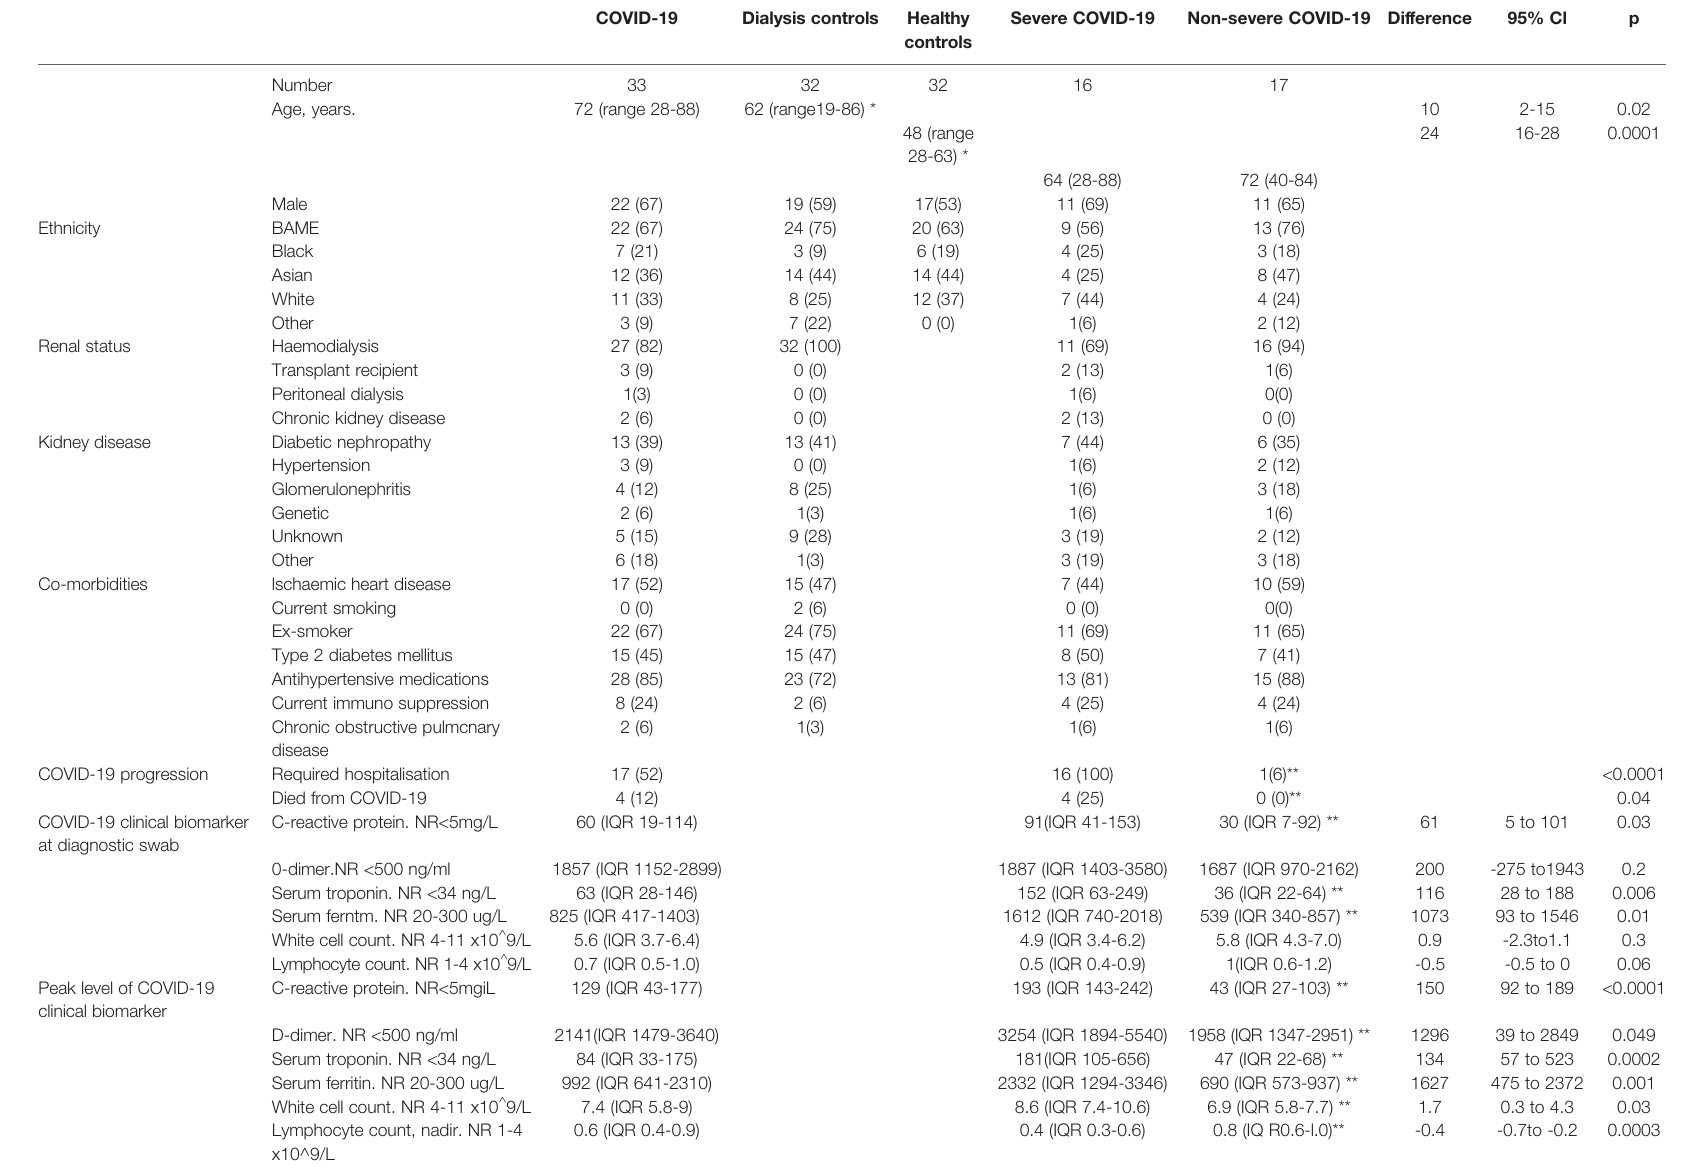
TABLE 1 | Characteristics of COVID-19 and control